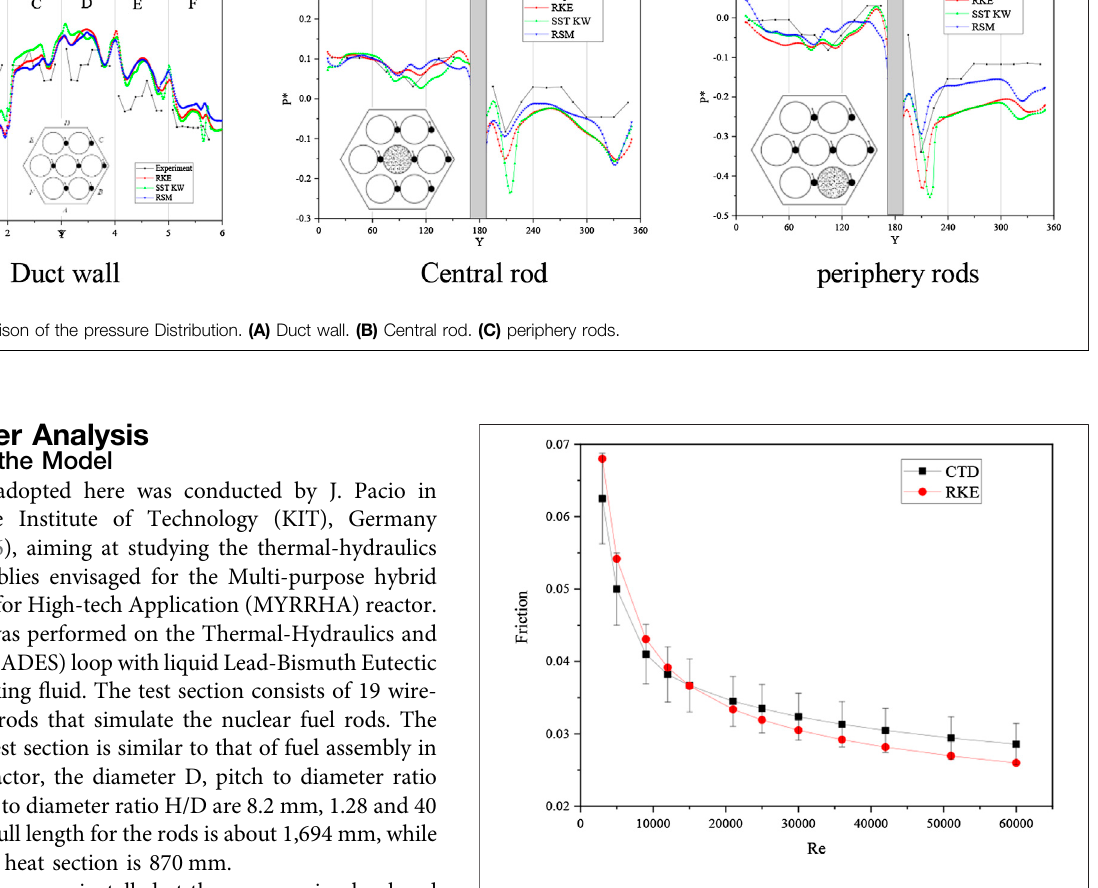
Frontiers in Energy Research |